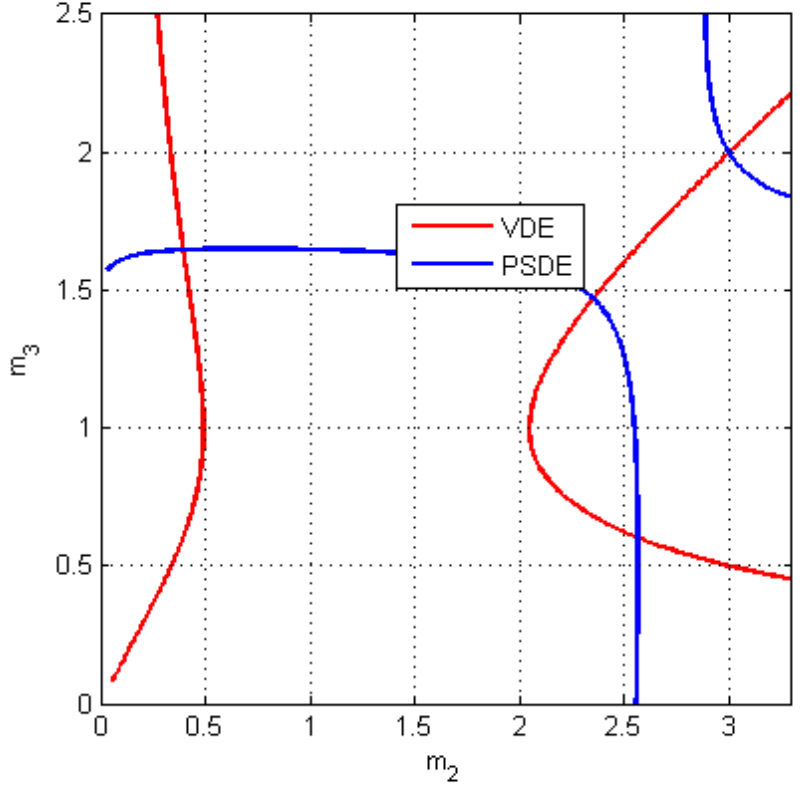
Figure 3. Solution of VDE and PSDE with NFOV inputs as the initial parameters.